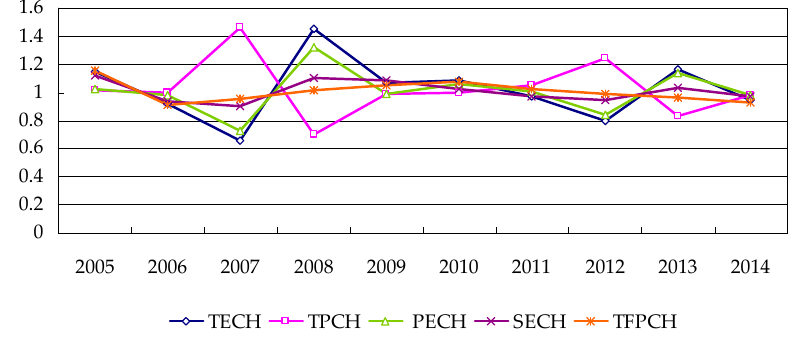
Figure 6. The efficiency index changes of Chinese thermal power industry from 2005 to 2014.